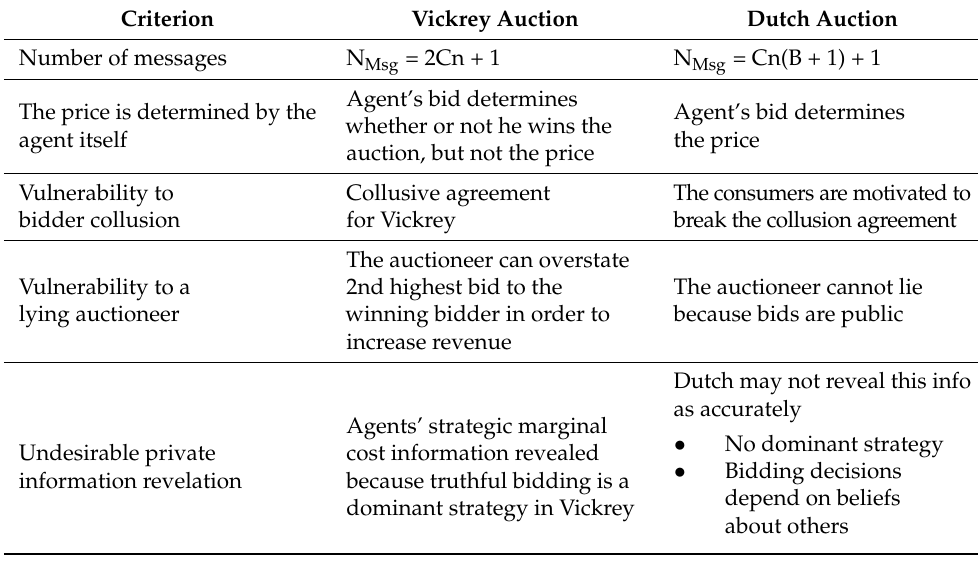
Table 5. Comparison between Vickrey and Dutch